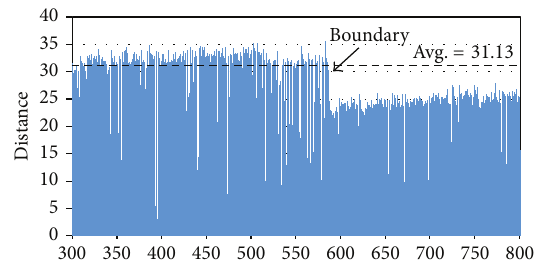
Figure 2: Chainmap diagram to our simulation result, where only the distances of cell numbers from 300 to 800 in the final state are shown.Theaveragedistanceofwholedatasetis 31.13 ,whiletheideal boundary is marked at the cell 𝑐 586